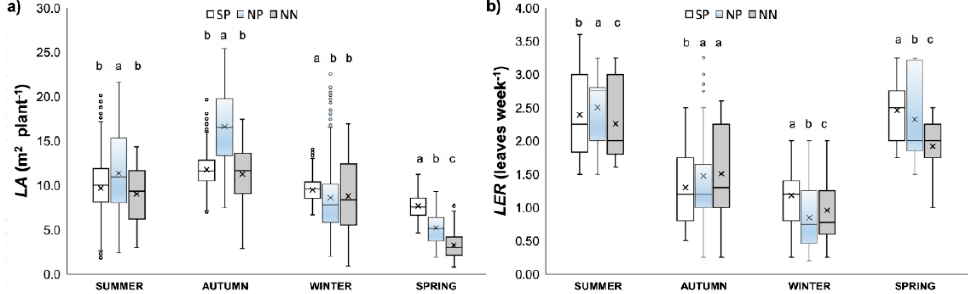
Figure 2. Seasonal trend of weekly leaf area (LA) ( a ) and leaf emission rate (LER) ( b ) in the papaya ( Carica papaya L. cv. Sweet Mary) greenhouses and the screenhouse: south and north with plastic cover (SP and NP) and north with net cover (NN). Winter (n SP = 230; n NP = 230; n NN = 200), spring (n SP = 130; n NP = 130; n NN = 130), summer (n SP = 184; n NP = 184; n NN = 172), and autumn (n SP = 184; n NP = 184; n NN = 184). The boxes are bounded on the top by the third quartile, and on the bottom by the first quartile. The median divides the box and the (x) represents the mean. The whiskers are error bars: one extends to the maximum and the other to the minimum. Any point outside ( ○ ) those whiskers is considered an outlier. Boxplots followed by the same letter are not significantly different according to the LSD test at a significance level of 0.05.